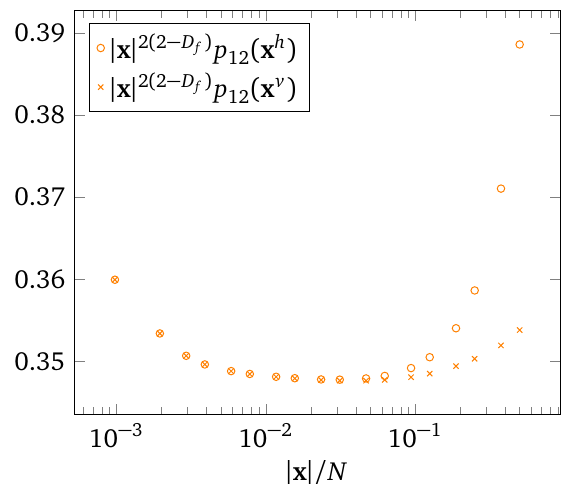
Figure 5: The connectivity measured for H = − 2 / 3, along the small cycle (circles) and the long cycle (crosses) of a torus with M / N = 2, N = 2 10 . The data points were obtained by averaging over 10 5 instances of the surface and over the N × M locations of x (cf. Section 3. The connectivity measured along the long cycle of the torus is always smaller than the connectivity measured along the small